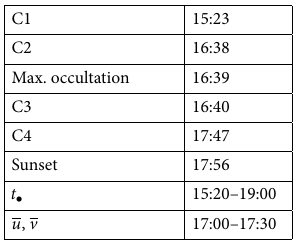
′ ′′ ′ ′′ 16.3 S 71°14 56.2